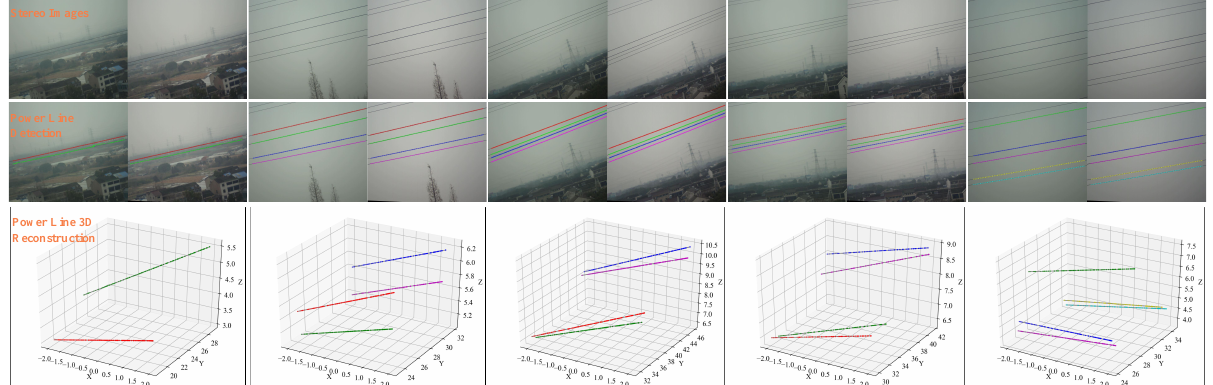
Figure 11. Power lines 3D reconstruction results of different